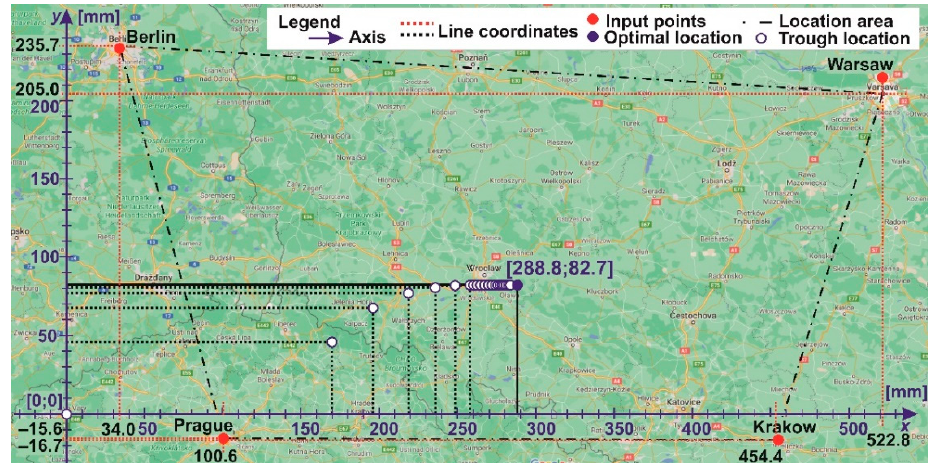
Figure 5. Graphical representation of the solution of the distribution centre’s location.